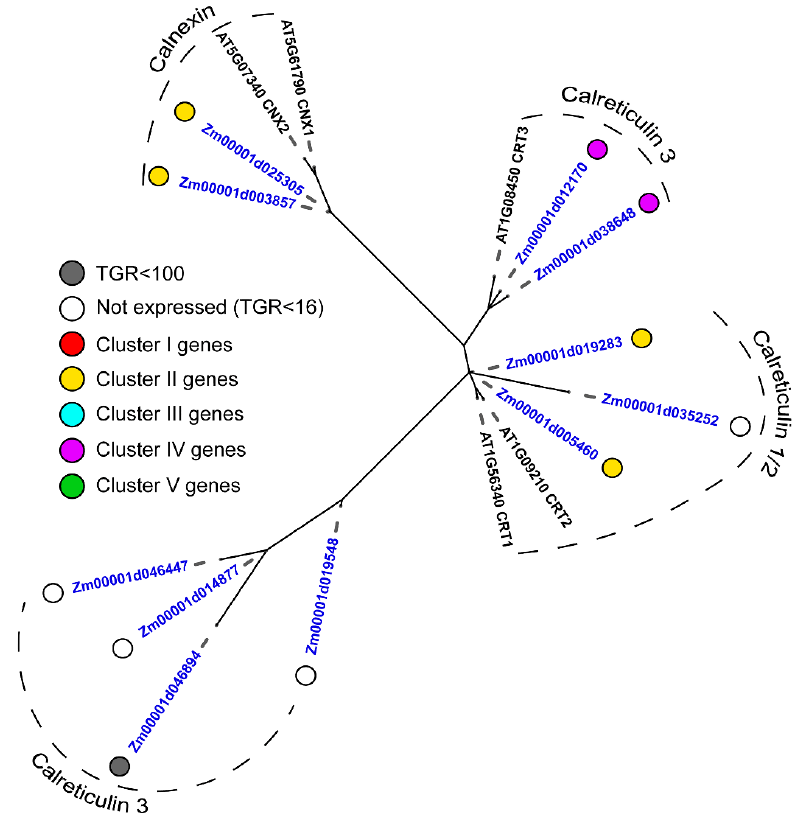
Figure 3. The phylogenetic dendrogram of calreticulin (PF00262) family members of A. thaliana (gene names are given in black font) and Z. mays (blue font). The colored dots next to Z. mays genes denote the character of expression: white—genes with no expression (TGR value less than 16 in all samples); gray—genes with a TGR value less than 100 in all samples; red—genes from cluster I, expression decreased from meristem and root cap zones to late elongation; yellow—genes from cluster II, expression peaks in the early elongation zone; blue—genes from cluster III, high expression from early to late elongation; purple—genes from cluster IV, expression increased in the root cap and also increased from meristem zone to late elongation; green—genes from cluster V, highest expression in the late elongation zone. Only branches with ultrafast bootstrap support values greater than 90 are